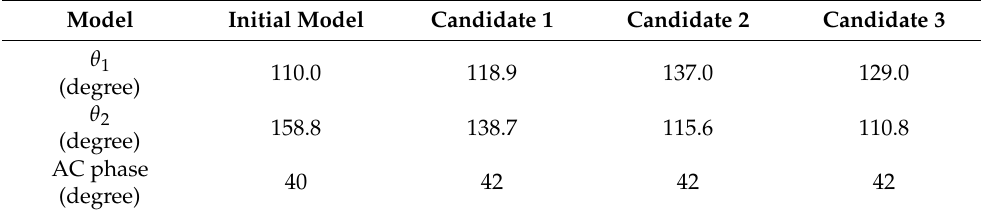
Table 4. Design variables of the initial model and three candidates.